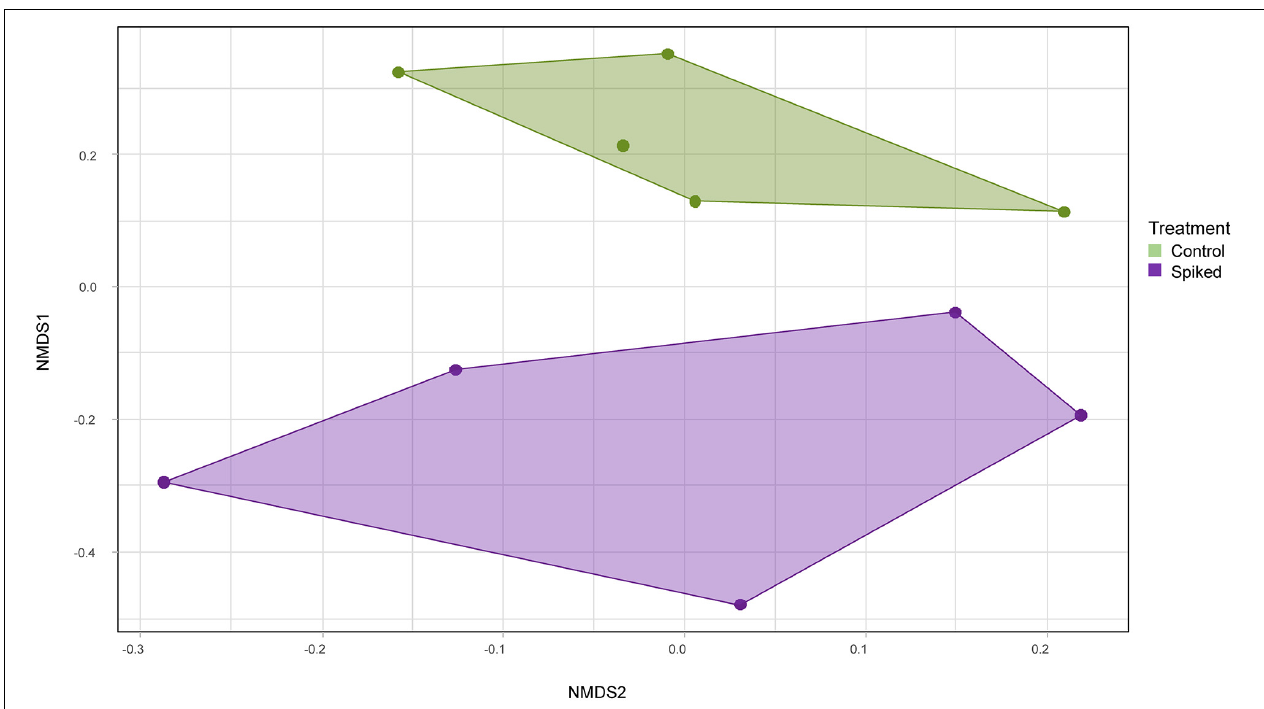
FIGURE 6 | NMDS of Bray-Curtis dissimilarities based on the relative abundance of all ASVs in the 18S rRNA dataset. Spiked (purple) and control (green) grouped distinctly with no overlap between